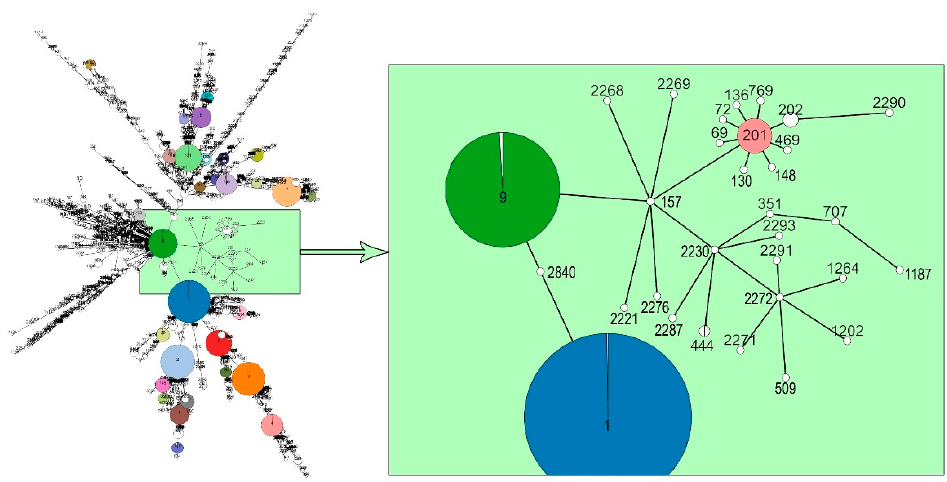
Figure 3. MLST tree minimum spanning tree demonstrating the genetic relatedness between L. monocytogenes strain 4/52-1953 (ST201) and all L. monocytogenes strains ( n = 5326) available in the BIGSdb-Pasteur MLST database (https://bigsdb.pasteur.fr/listeria/listeria.html, accessed on 7 March 2022). Each individual circle represents one sequence type (ST). The circle sizes are proportional to the number of strains. Links between circles represent the number of allelic mismatches between indi- vidual STs (Supplementary Data S1). The position of ST201 regarding to all STs is shown in green square.